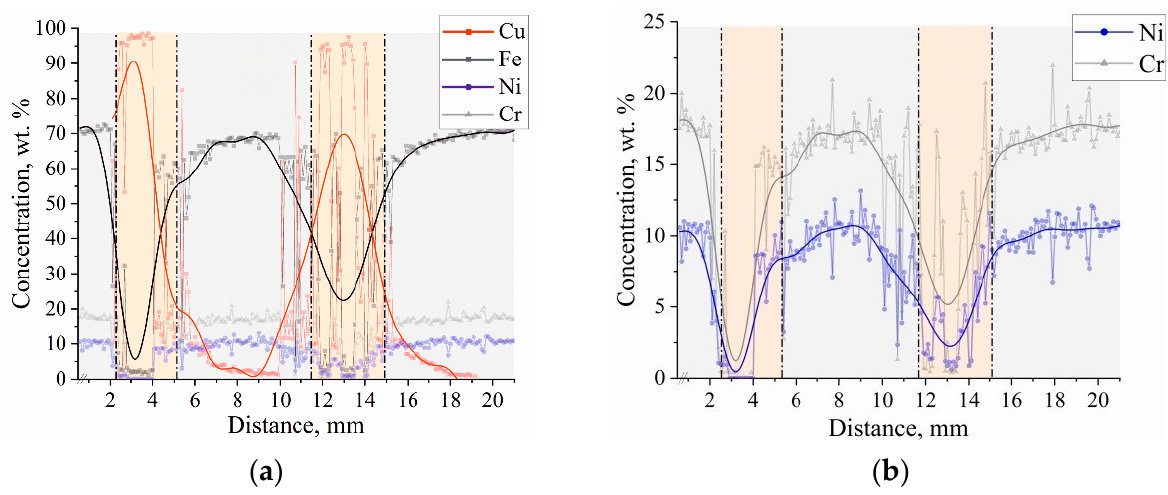
Figure 10. Changes in the elemental composition (SEM EDS analysis) with the distance from the substrate in bimetal laminate macrocomposite ( a ) produced by electron beam additive manufacturing and changes elements necessary for the analysis of equivalents ( b